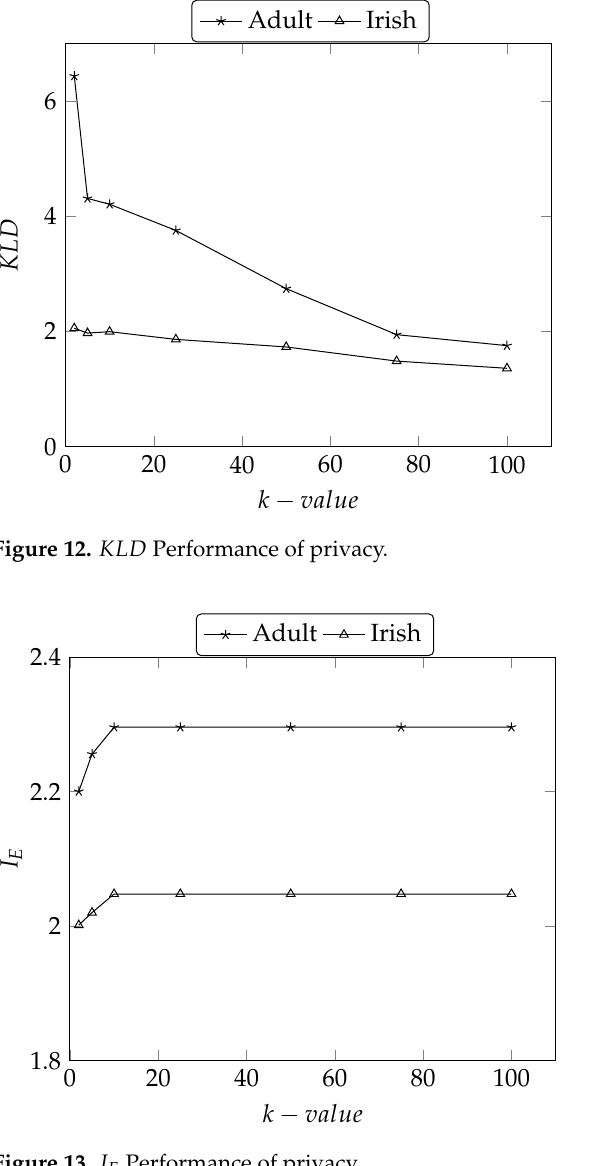
Figure 13. I E Performance of